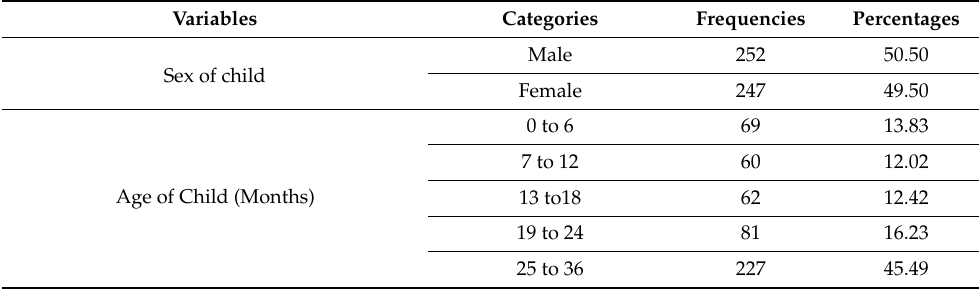
Table 2. Descriptive analysis describing the association between different socioeconomic characteris- tics over CIAF (child